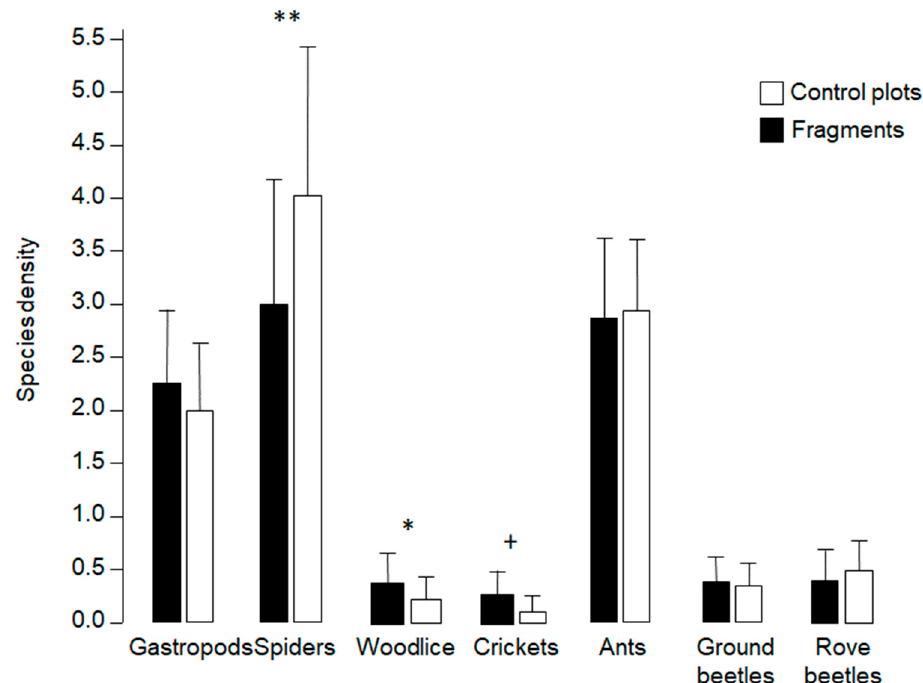
Figure 4. Species density of invertebrate groups in fragments and control plots in the final year of the experimental fragmentation. Species density was calculated as the mean of two pitfall traps per fragment or control plot averaged over seven 2-week collections. Only large and small plots were used. Means ± SD are shown; n = 24; + p < 0.10, * p < 0.05, ** p < 0.01. Data from [42].